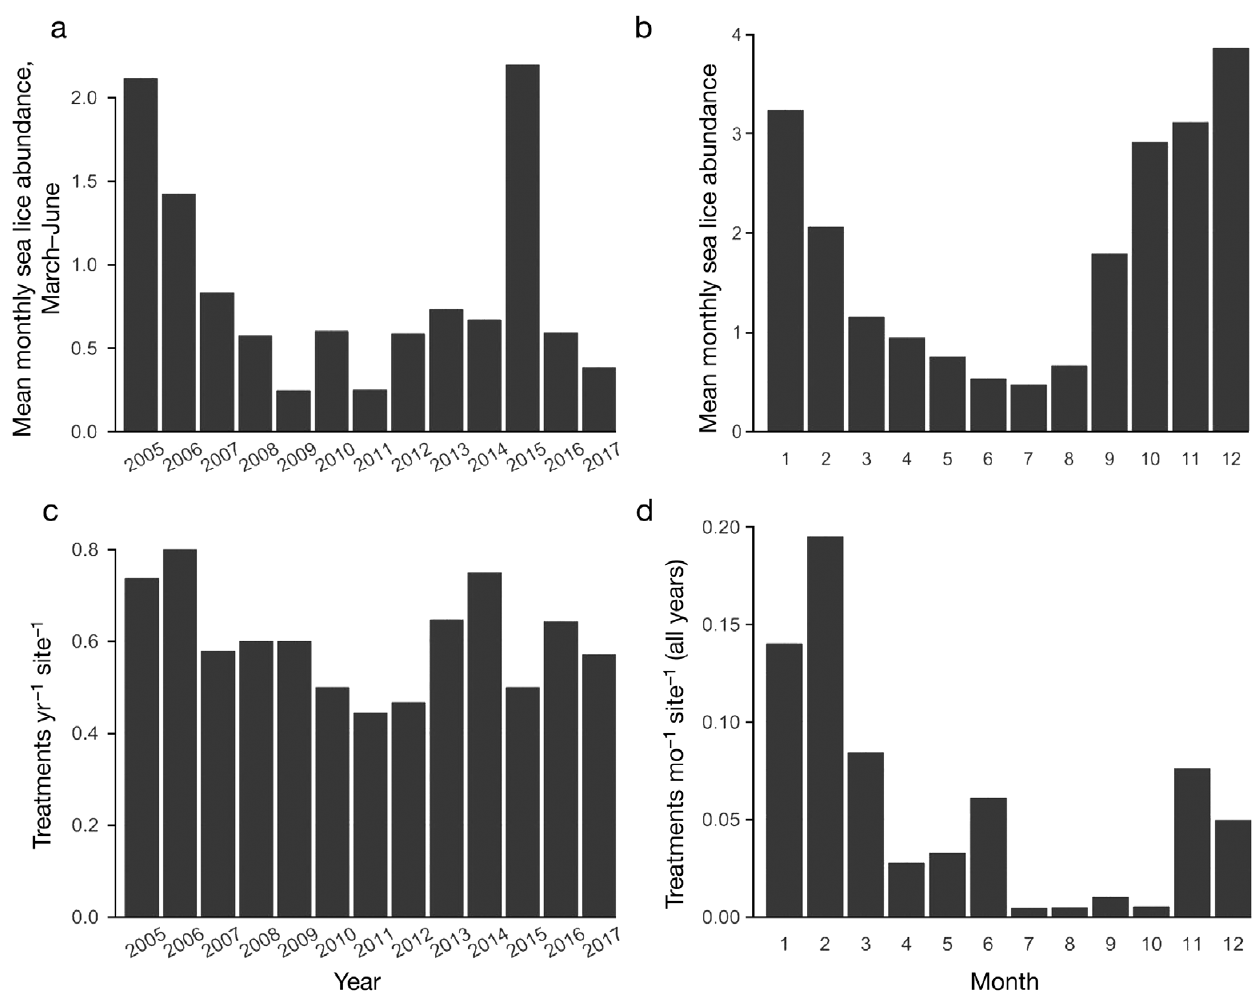
Fig. 3. (a) Mean motile sea lice abundance for (a) the months March−June for all sites over the years 2005−2017 and (b) all sites between 2005−2017 broken down by month. Treatments (c) per year (summed across all sites and months) from 2005−2017, and (d) per month (summed across all years and